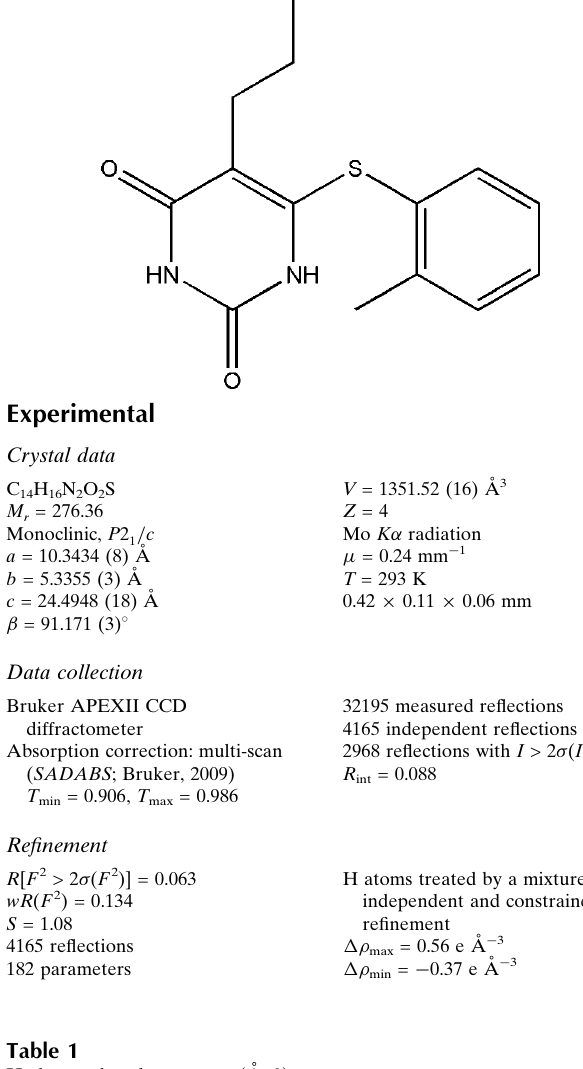
Hydrogen-bond geometry (A˚ , (cid:2) ). Cg 1 and Cg 2 are the centroids of C1–C6 and C8–C11/N1/N2 rings,